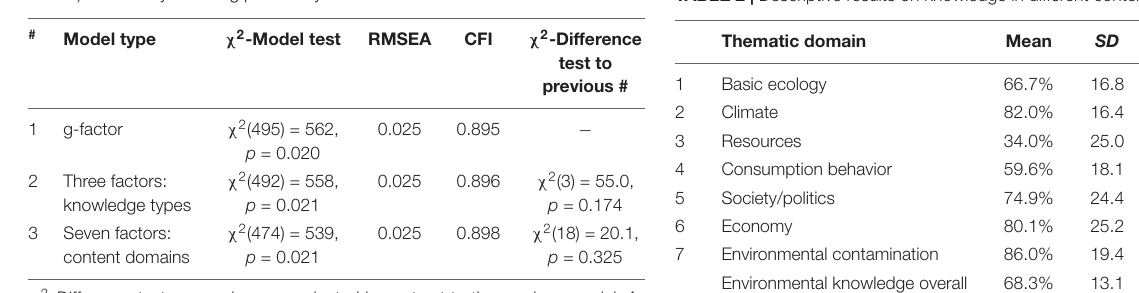
TABLE 2 | Descriptive results on knowledge in different content